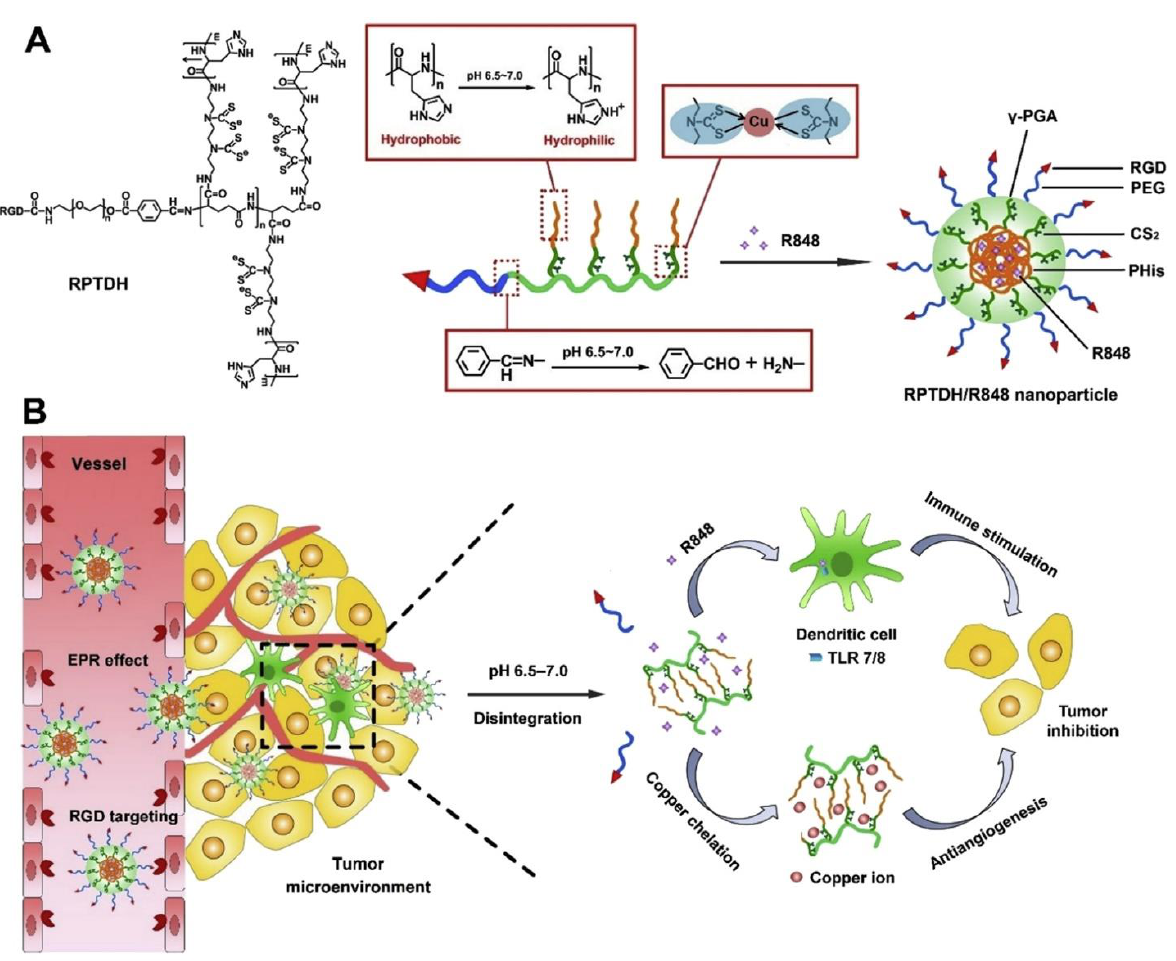
Figure 7. Illustration of the ( A ) preparation of the RGPPTDHist-R848 NPs and ( B ) its mechanism of action in breast cancer cells [178].